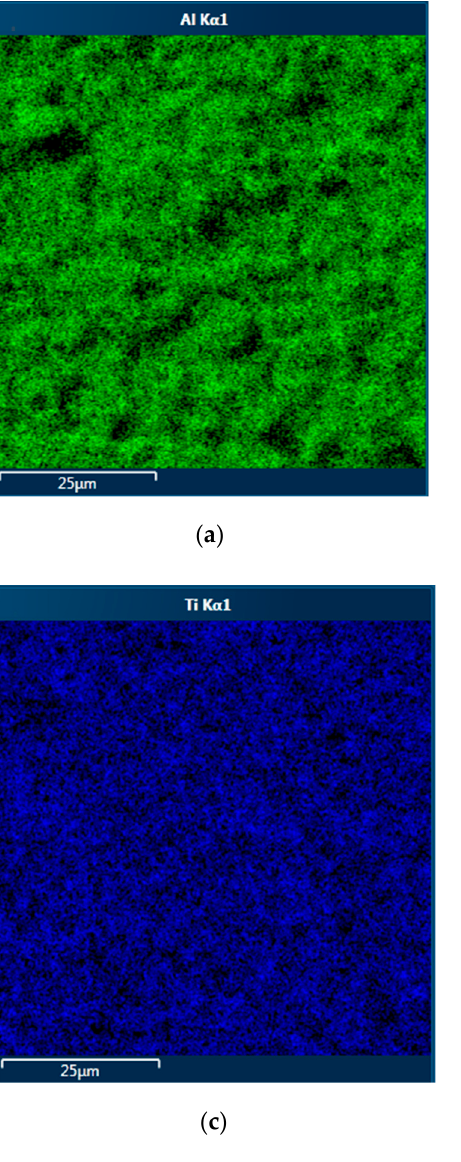
( d ) Figure 8. Elemental mapping of the Al 2 O 3 + 30%TiC nanocomposite machined surface in water medium: ( a ) Aluminum; ( b ) Oxygen; ( c ) Titanium; ( d ) Carbon.